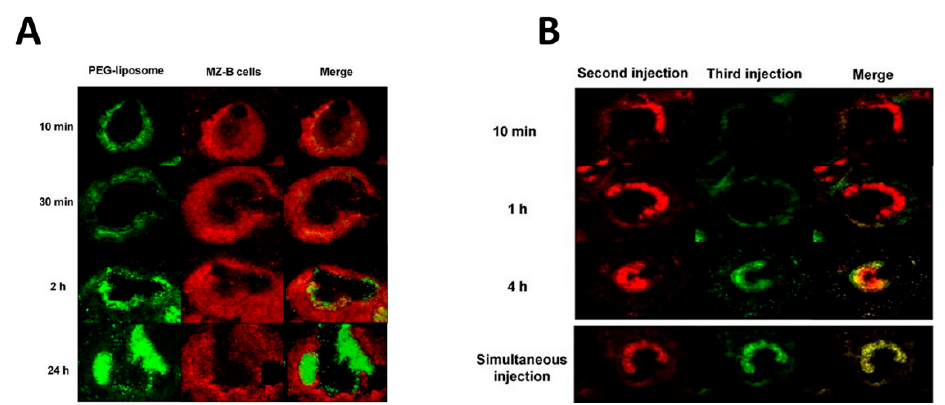
Figure 4. Kinetics of nanoparticle diffusion into the spleen during the accelerated blood clearance (ABC) phenomenon. ( A ) Migration of PEGylated liposomes from the marginal to the follicular zone during the accelerated blood clearance (ABC) phenomenon. The left part of the panel shows fluorescence images obtained 10 min, 30 min, 2 h and 24 h after the injection of fluorescent green PEGylated liposomes in rats in which ABC had been induced by previous administration of non-fluorescent PEGylated liposomes. The middle of the panel shows in the red marginal zone macrophages at the same times, whereas on the right, the merging of the green and red images is reported. Notice that green fluorescence moves from the marginal into the follicular zone where it is almost completely located after 24 h; ( B ) PEGylated liposomes injected at different times independently migrate from the marginal to the follicular zone. After inducing ABC with the injection of a first dose of PEGylated liposomes, a second and a third dose were injected four hours, one apart from the other. To independently track liposomes from the two injections, red and green fluorescent liposomes were used for the second and for the third injection, respectively. Images in the right and in the middle of the panel were obtained 10 min, 1 h and 4 h from the injection of the second and of the third dose as indicated, whereas, on the right, the merging of these images is reported. Notice that both after the second and after the third dose, fluorescent liposomes migrate from the marginal to the follicular zone. In addition, merged images show that when green liposomes from the third injection start accumulating into the marginal zone, those from the second injection (red) are already in the follicular zone. This suggests that the migration process is quick and that liposomes from different injections migrate independently inside splenic white pulp. Images in the bottom of the panel show that when red and green PEGylated liposomes are injected simultaneously, they migrate at the same time from the marginal into the follicular zone. ( A , B ) are both reproduced from [127] with permission from the publisher.